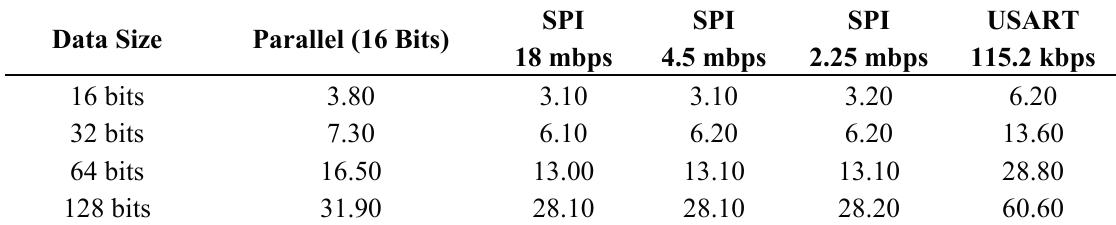
Table 3. Time intrusion in sensor node for each log event (ms).